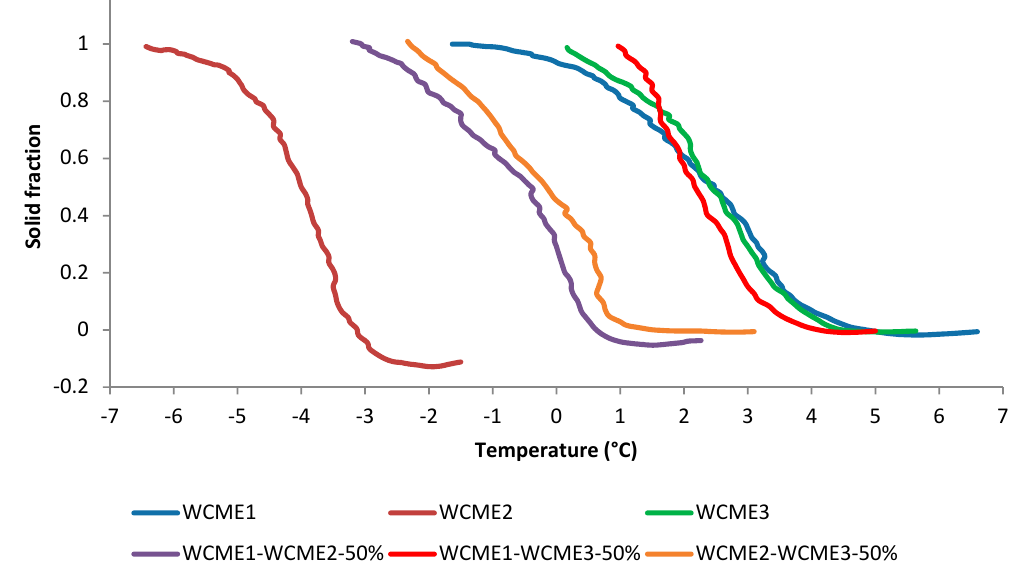
Figure 10. Variation of solid fraction during freezing of some selected biodiesel samples.